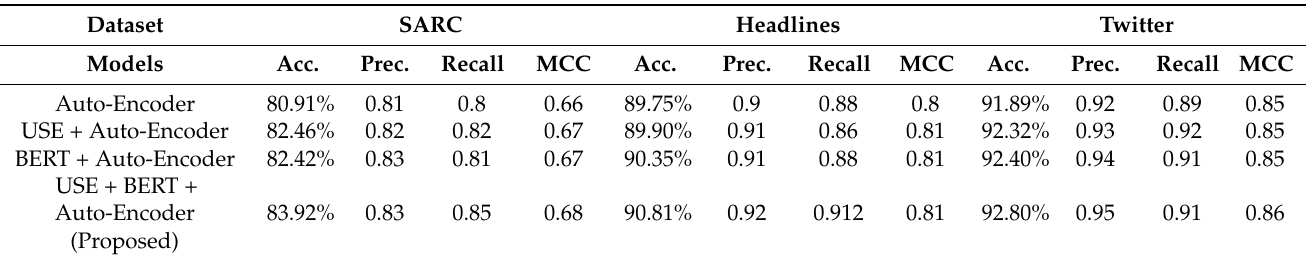
Table 1. Performance metric of the proposed models on three datasets.